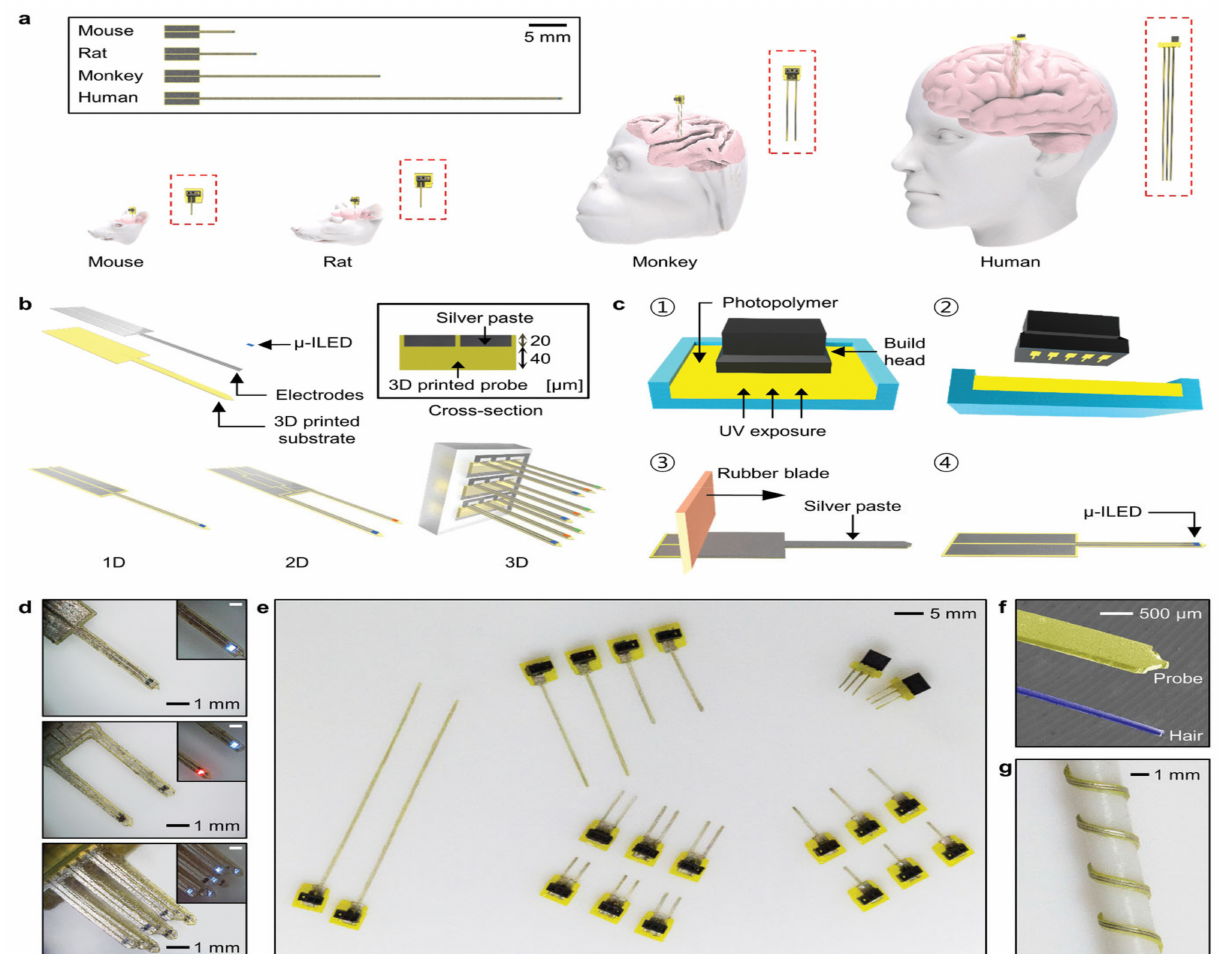
Figure 4. ( a ) Image demonstrates the customizability in terms of scale, allowing for various mam- malian brains to use 3D-printed optogenetic probes (3DP-OPs). ( b ) Design and architecture of 3DP-OPs. ( c ) Manufacturing sets of 3DP-Ops: ( 1 (cid:13) ) printing probe via SLA, ( 2 (cid:13) ) removal of probe and washing off excess residue, ( 3 (cid:13) ) application of silver paste to microgroove surface of probe and transverse the surface longitudinally with a rubber blade, ( 4 (cid:13) ) attaching microscale inorganic light emitting diode ( µ -ILED) to probe tip. ( d ) Optical images indicating customizability in structural design and different colored µ -ILEDs. ( e ) Printed 3DP-OPs showing different lengths ( f ) Thickness of the 3DP-OPs (yellow) against that of a human hair (blue). ( g ) Flexibility of the 3DP-OPs, which are wrapped around a 1.5 mm rod